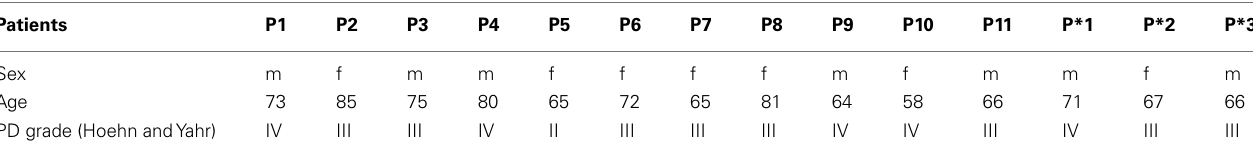
Table 1 | Demographic data and stage of disease of the PD patients.